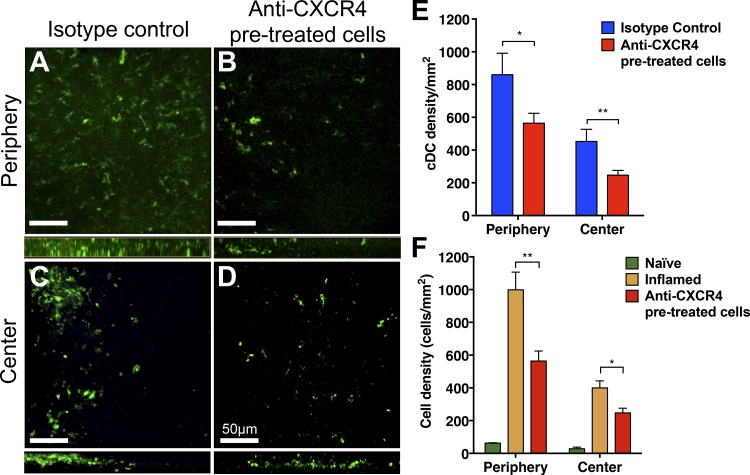
CXCR4 blockade decreases the recruitment of adoptively transferred cDCs. Pretreatment of adoptively transferred cDCs with anti-CXCR4–neutralizing monoclonal antibody reduces infiltration of adoptively transferred cDCs into the peripheral (A, B) and central (C, D) cornea 24 hours after injection compared with isotype control treatment, n = 7/group. Density quantification of cDC infiltration treated ex vivo with anti-CXCR4–blocking antibody reveal a significant decrease in the number of adoptively transferred cells compared with the appropriate isotype control (E) and total infiltration (F) into suture inflamed corneas. Scale bars denotes 50 μm. Data are shown as mean ± SEM. *P < 0.05, **P < 0.01. n = 4–7/group.